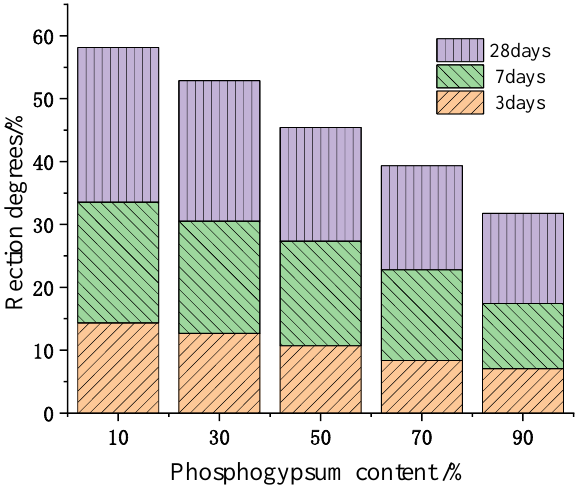
Figure 1. Reaction degree of phosphogypsum.